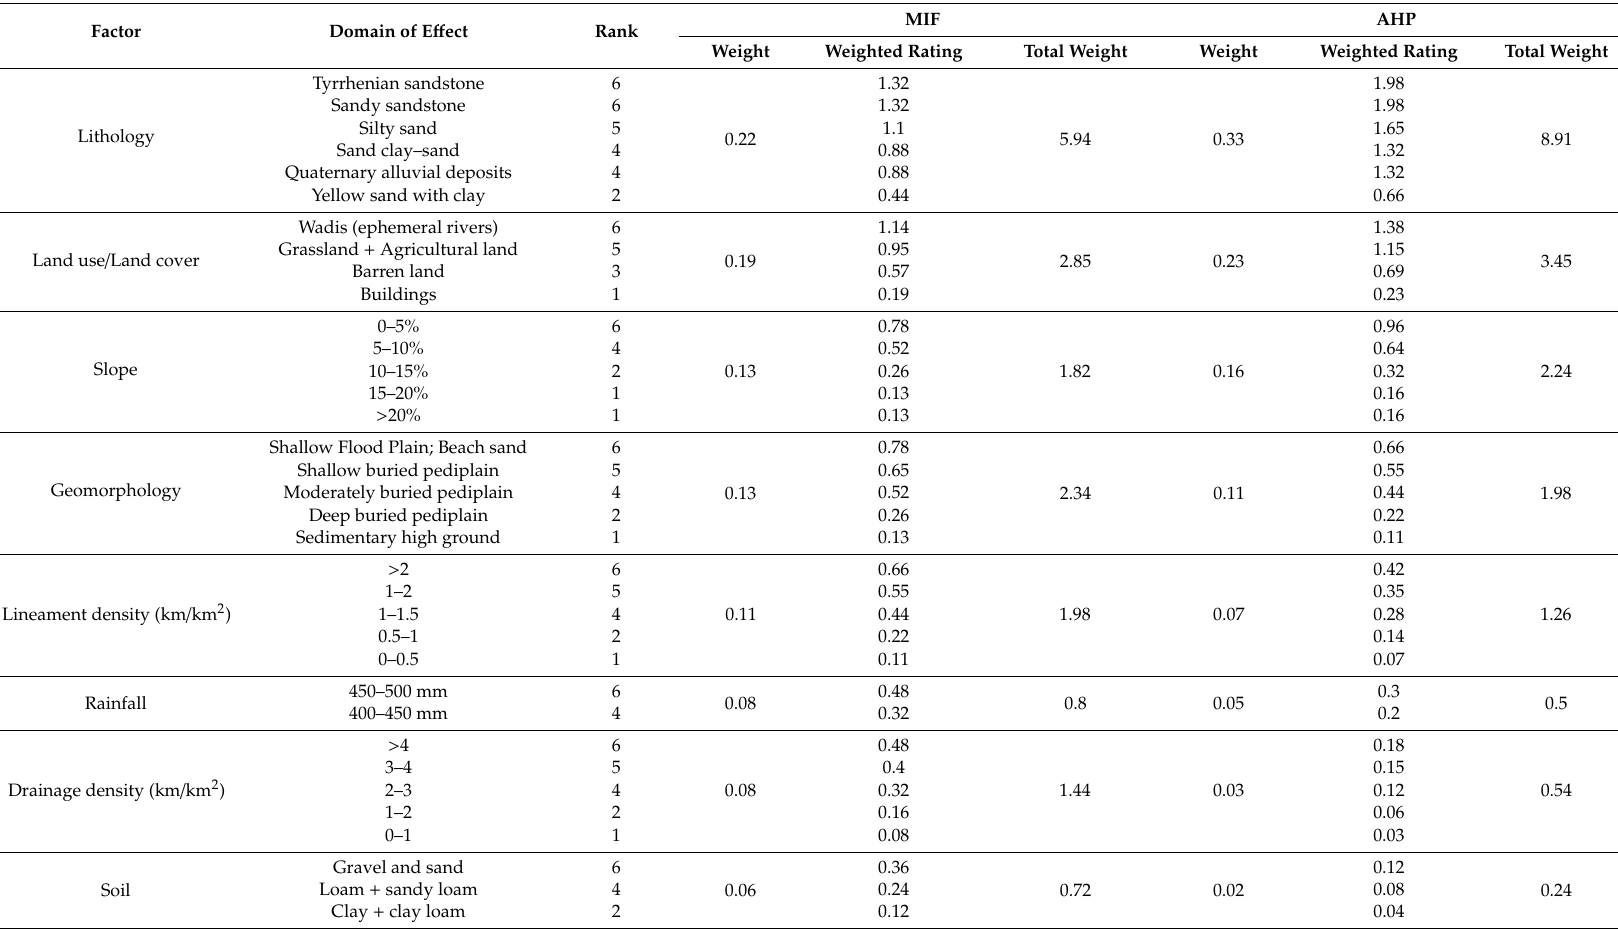
Table 8. Criteria-assigned ratings and weights for AHP and Multi-Influencing Factors (MIF)